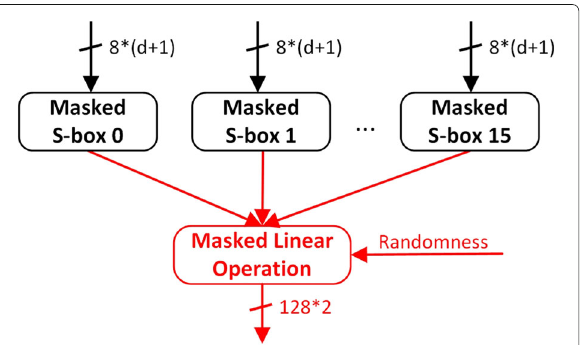
half costs. However, designing the masked MixColumns module is the most complex and significant for improv- modules.